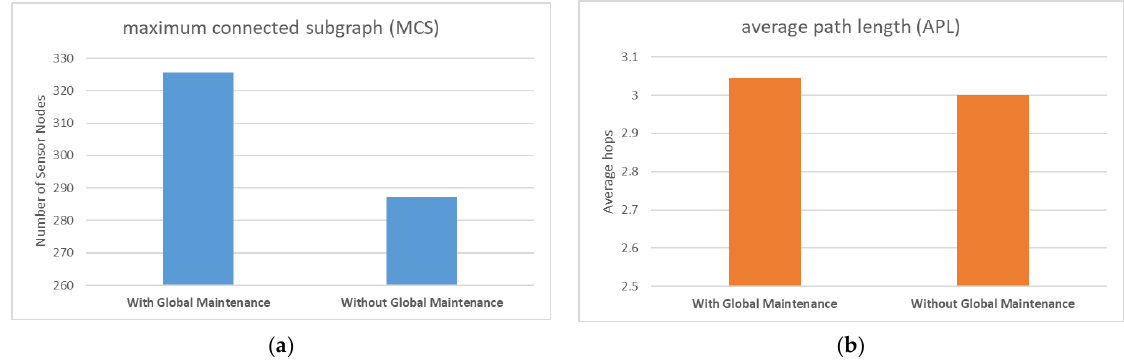
Figure 9. ( a ) Comparison of MCS with or without a global maintenance mechanism; ( b ) Comparison of APL with or without a global maintenance mechanism.